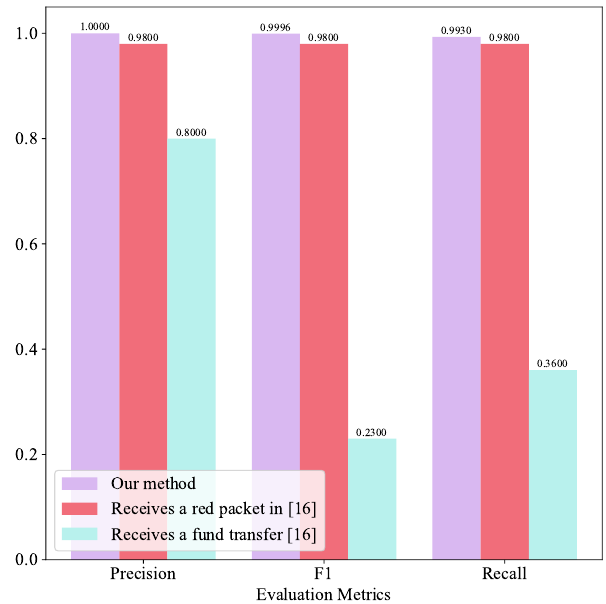
Figure 11. Performance comparison between proposed classifier and that of [16].